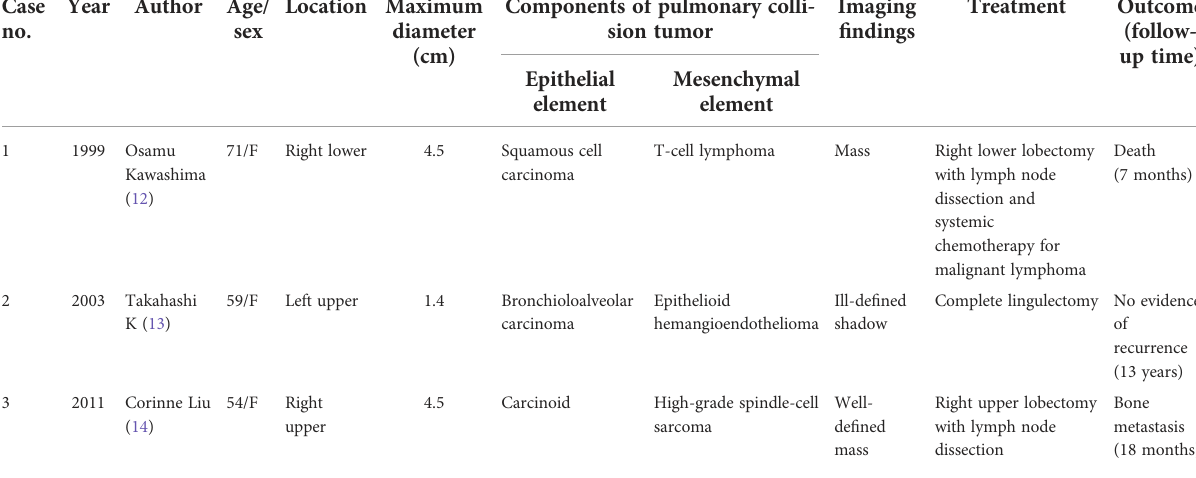
TABLE 2 Summary of published pulmonary collision tumors comprising epithelial and mesenchymal elements found in the literature. Case no.